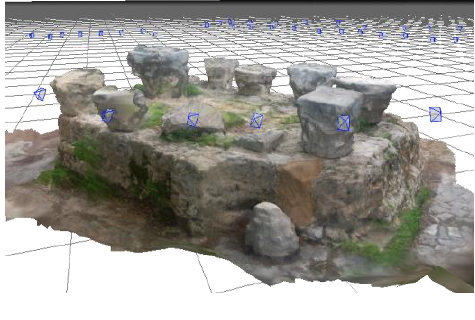
Figure 7- Photomodelling of capitals in the site museum of Carthage using Zephyr 3D.